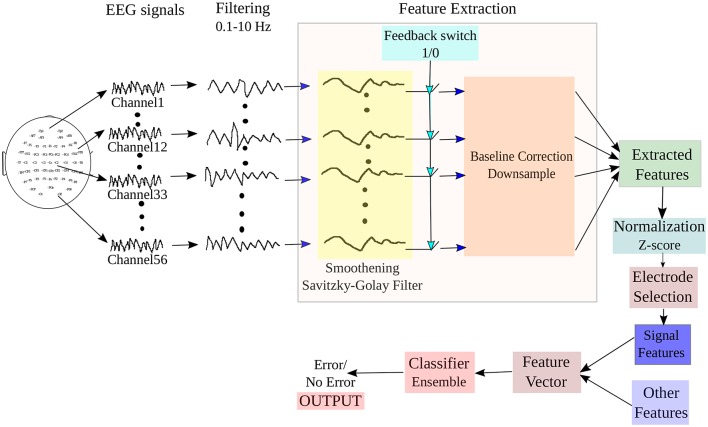
Block diagram of the BCI system adopted for online detection of ErrP signals from the input EEG.